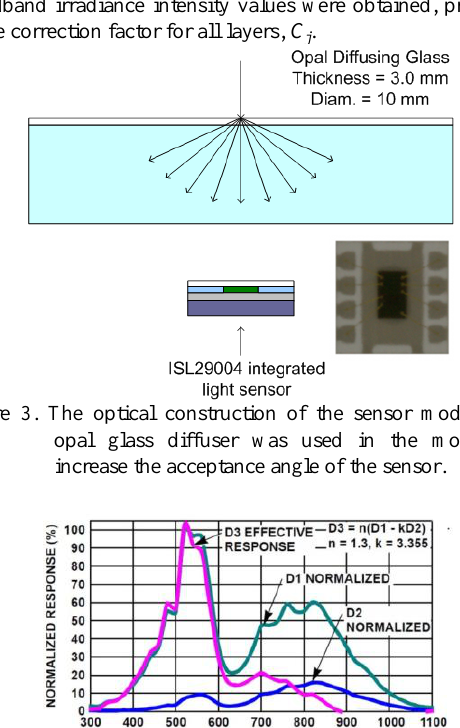
Figure 4. Relative spectral response plot of the Intersil ISL29004 photodetector. The normalized D2 output was used in the down dwelling irradiance sensor module.